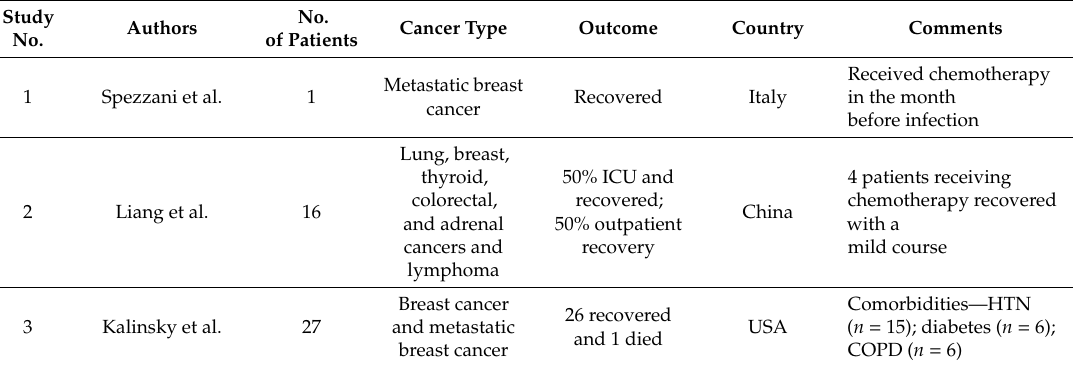
Table 1. Clinical outcomes and characteristics of severe acute respiratory syndrome coronavirus 2 (SARS-CoV-2)-infected cancer